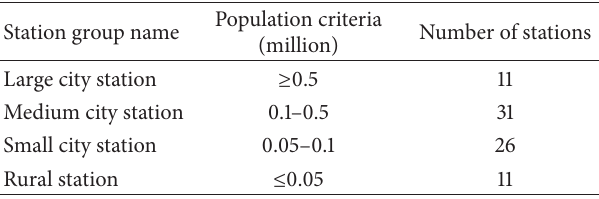
Table 2: Numbers of stations for each station group in the JJJ area.